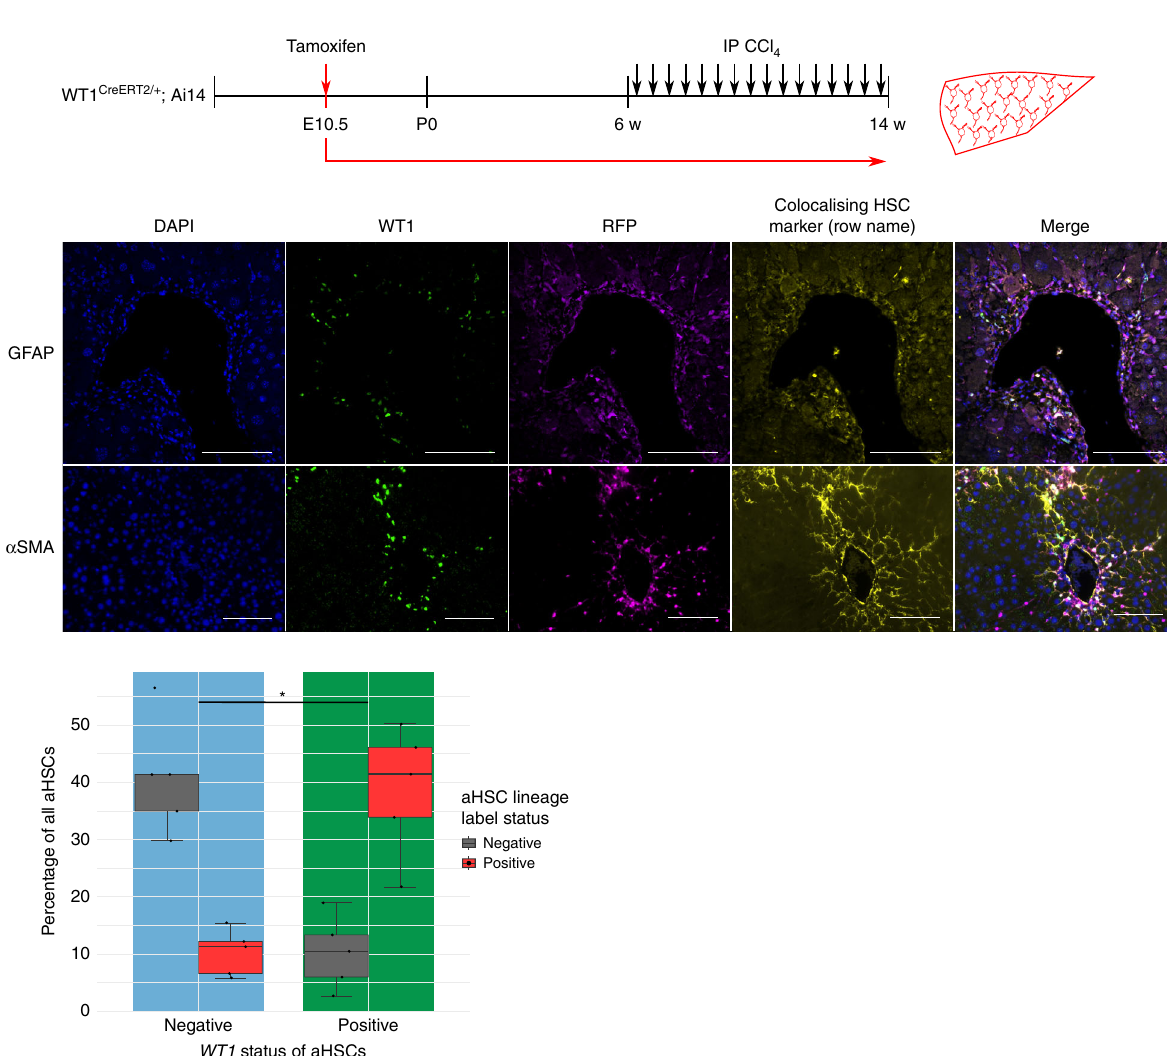
GFP positive (Supplementary Fig. 3). In fully activated cultures, 30.4 ± 4.6% of cells were WT1 positive ( n = 12 animals). Within the WT1-positive population, two distinct populations were identi fi ed; 49.3 ± 6.7% of WT1-positive cells were GFP-high and the remainder GFP-intermediate (Fig. 4a). WT1 expression of sorted subpopulations by qPCR correlated with GFP intensity (Spearman ’ s rank correlation r s = 0.962, p = 1.009 × 10 – 8 , n = 5 animals, Supplementary Fig. 3). All sub- populations expressed the well-characterised fi brogenic activation markers Acta1 , Timp1 , and Col1a1 (Fig. 4b). For each gene, there was a statistically signi fi cant difference between groups deter- mined by one-way ANOVA ( Acta1 F (2,12) = 11.72, p = 0.0015; Timp1 F (2,12) = 11, p = 0.0019; Col1a1 F (2,12) = 4.496, p = 0.0349). The WT1-intermediate subpopulation showed higher expression by post-hoc Tukey testing ( p < 0.05).